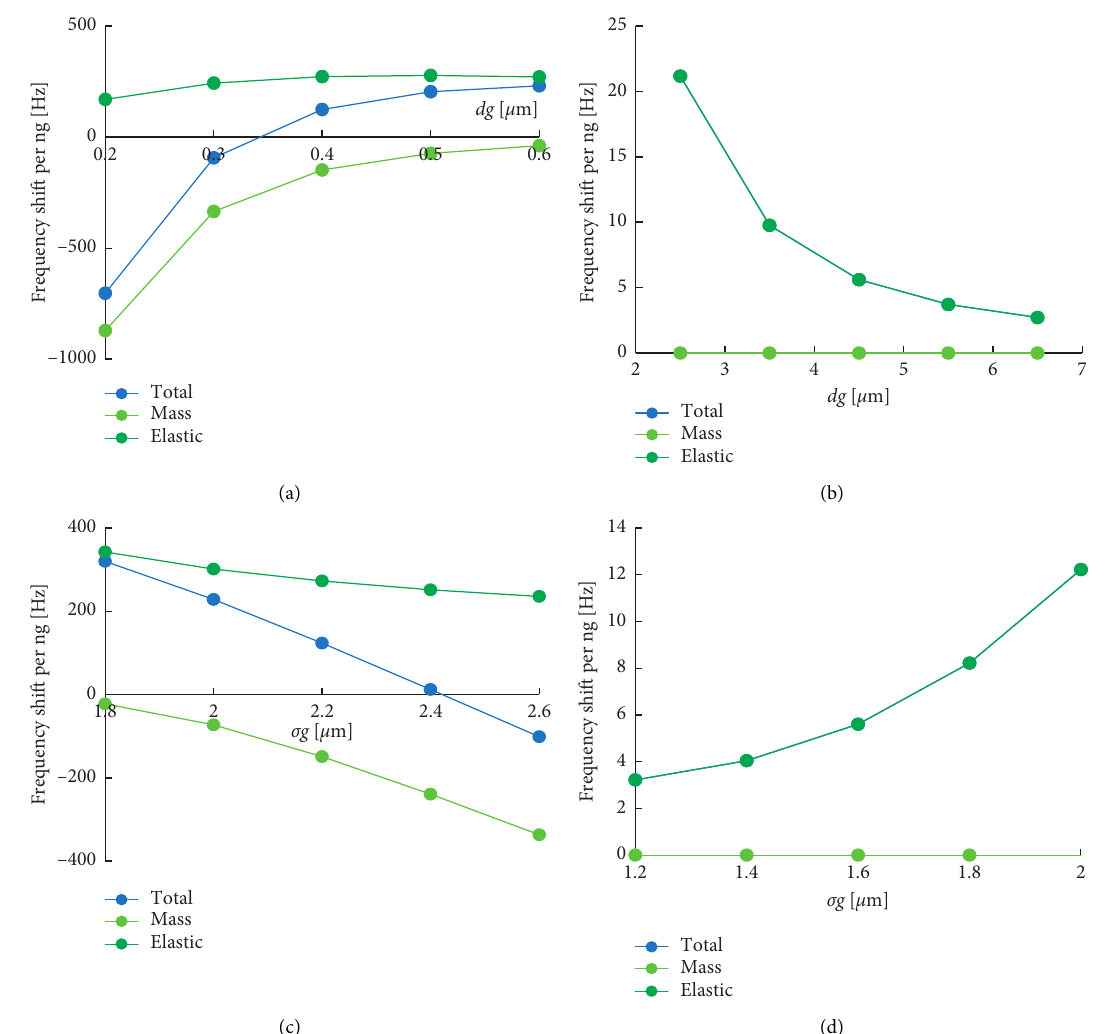
Figure 3: SAW Sensitivity vs. geometric mass mean diameter d σ g � 2.2. (b) PM10 with d g � 2.5 ∼ 6.5 μ m and σ g � 1.6. (c) PM2.5 with d g � 0.4 μ m and σ g � 1.8 ∼ 2.6. (d) PM10 with d g � 4.5 μ m and σ g � 1.2 ∼